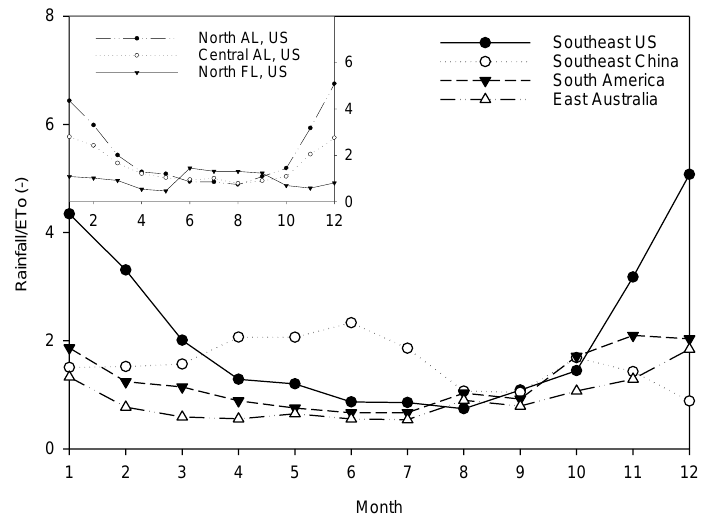
Figure 4. Mean monthly rainfall/potential evapotranspiration (ET o ) ratio for reference locations in the main humid subtropical regions in the southeast U.S., southeast China, South America, and east Australia. Monthly means based on data from 1981 to 2010. Months 1 to 12 in the Northern Hemisphere represent January to December, whereas in the Southern Hemisphere 1 to 6 correspond to the period from July to December and 7 to 12 from January to June [39] . Top left monthly rainfall/ET o ratio for three locations within the southeast U.S. humid subtropical region, including reference locations: north Alabama, central Alabama, and north Florida. Inlet figure units are the same as the main figure.